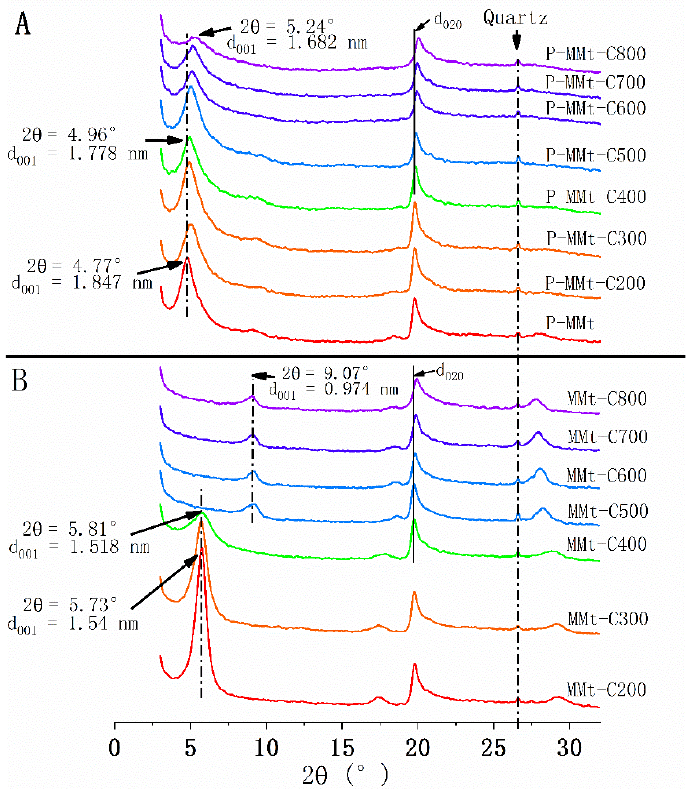
Figure 2. XRD patterns of P-MMt ( A ) and MMt ( B ) calcined at different temperatures.